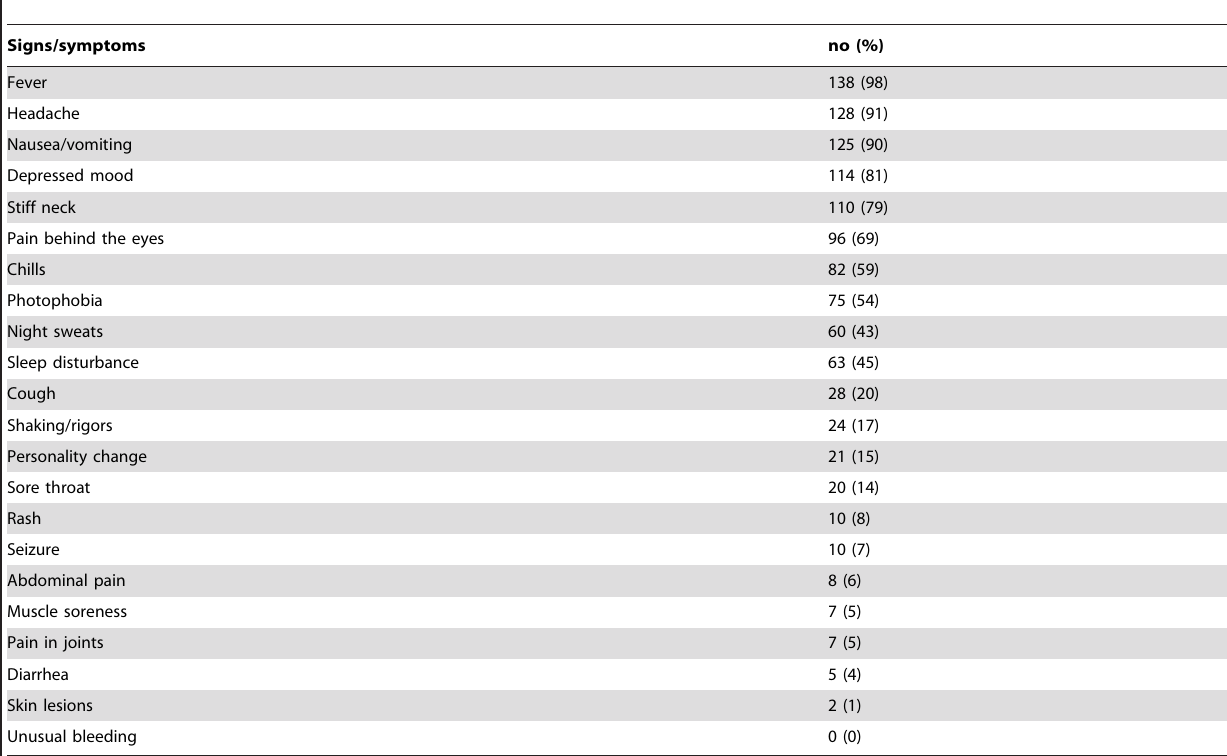
Table 2. Frequency of signs and symptoms among 140 patients presening with acute febrile central nervous system syndrome, country of Georgia.